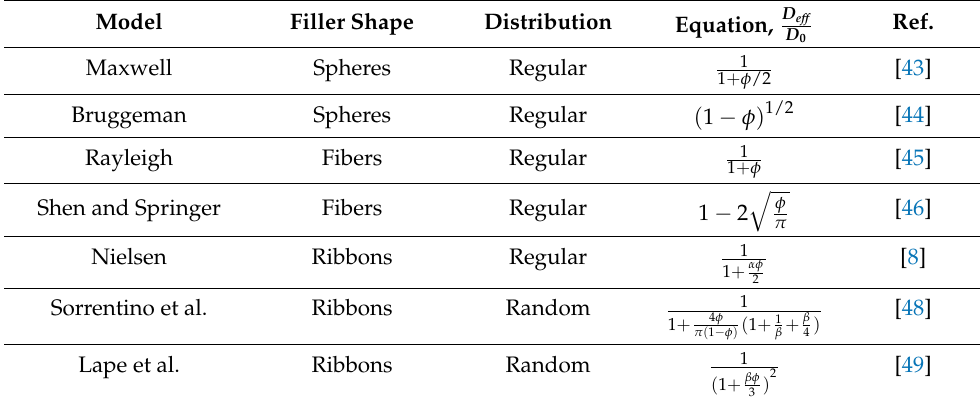
Table 1. Analytical equations predicting the relative effective diffusivity values of composite